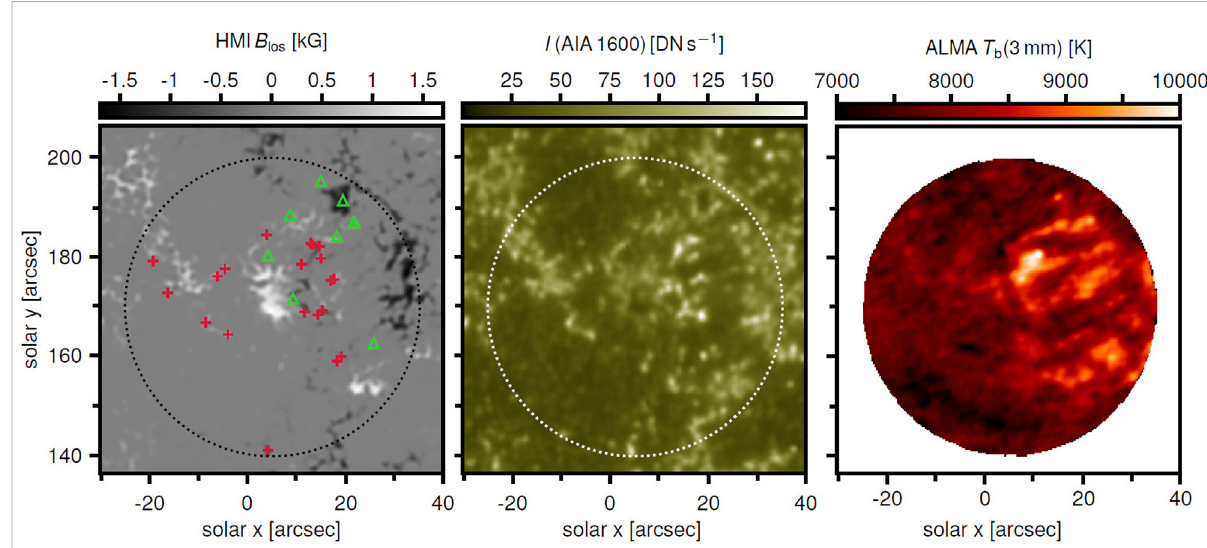
FIGURE 9 A small active region observed by SDO and ALMA. The left image is a longitudinal magnetogram from HMI/SDO, the middle image has been obtainedbyAIA/SDOwhiletherightimageshowstheALMA3 mmemission.ThedottedcirclesshowtheALMA fi eldofview.Inthemagnetogramthe crosses mark the locations of Ellerman bombs. The triangles indicate locations of transient brightenings detected by both AIA and ALMA (adapted from da Silva Santos et al., 2020). Reproduced with permission ©